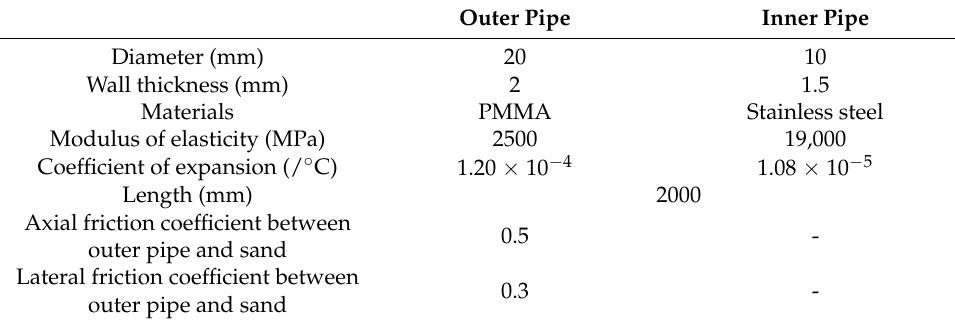
Table 1. Parameters in the literature.